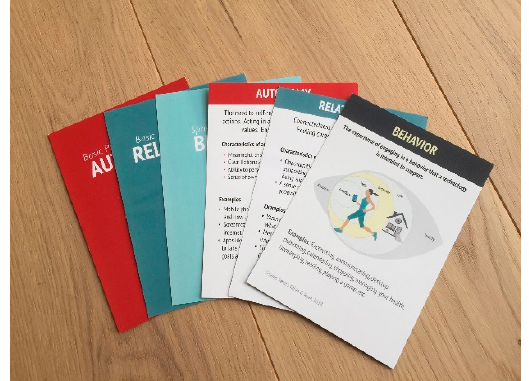
Figure 2. Cards from the “wellbeing design cards” deck.